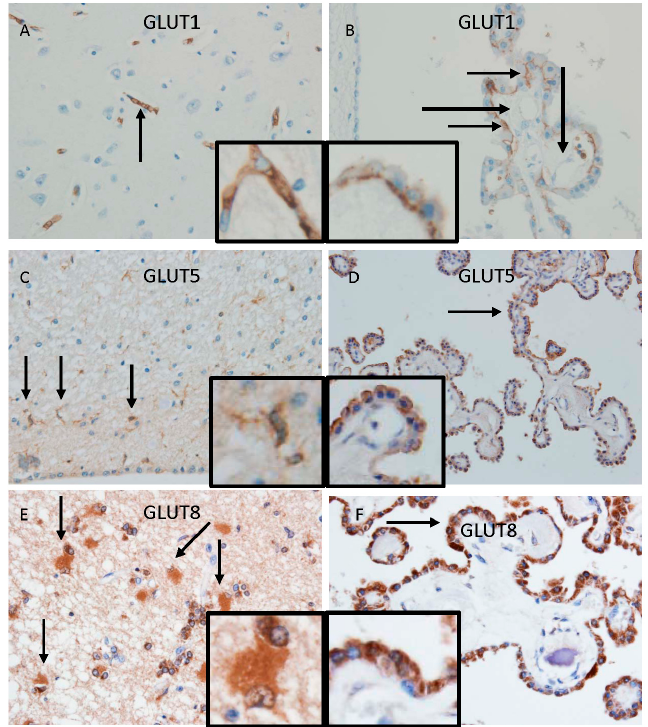
Figure 2. Immunohistochemical localization of representative transporters for glucose (GLUT1) and fructose (GLUT5 and GLUT8) at the BBB and the BCSFB. Microphotographs of immunohistochemical staining using antibodies for GLUT1 ( A , B ), GLUT5 ( C , D ), and GLUT8 ( E , F ) are shown. Immunoreactivity of GLUT1 is observed in the vessel wall in the cortex ( A : arrow) and in cytoplasmic membrane of epithelial cells ( B : arrow), but not in the vessel wall ( B : long thick arrow), in the choroid plexus. Insets; high magnification images show the localization of immunoreactivity in endothelial cells ( A ) and basal cytoplasmic membrane of epithelial cells ( B ). Immunoreactivity of GLUT5 is observed in microglial cells ( C : arrow) and in cytoplasmic membrane of epithelial cells of the choroid plexus ( D : arrow). Insets; high magnification images show the localization of immunoreactivity in processes of microglial cells ( C ) and in apical cytoplasmic membrane of epithelial cells in the choroid plexus ( D ). Immunoreactivity of GLUT8 is observed in the cytoplasm of astroglial cells ( E : arrow) and epithelial cells of the choroid plexus ( F : arrow). Insets; high magnification images show the localization of immunoreactivity in the cytoplasm of astroglial cells ( E ) and epithelial cells in the choroid plexus ( F